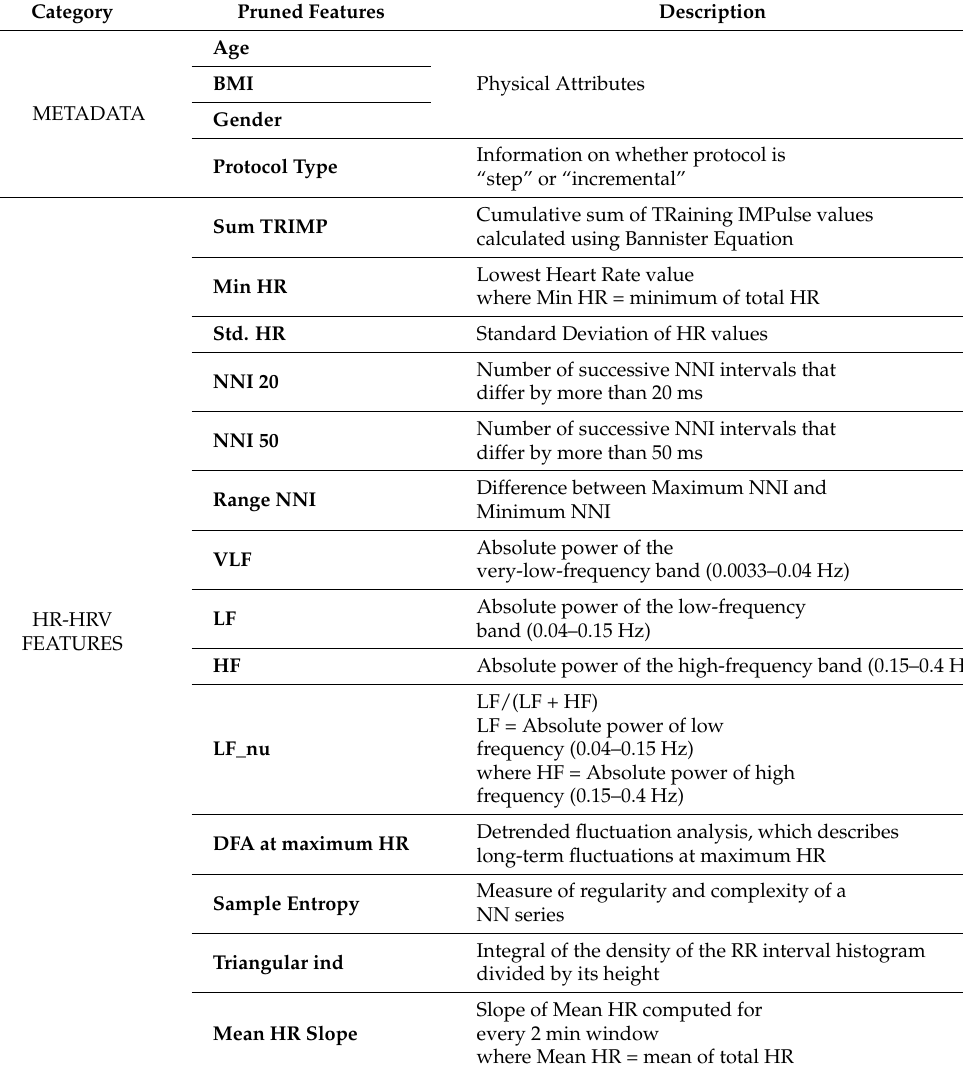
Table A1. Correlation–based Pruned Features for exercise